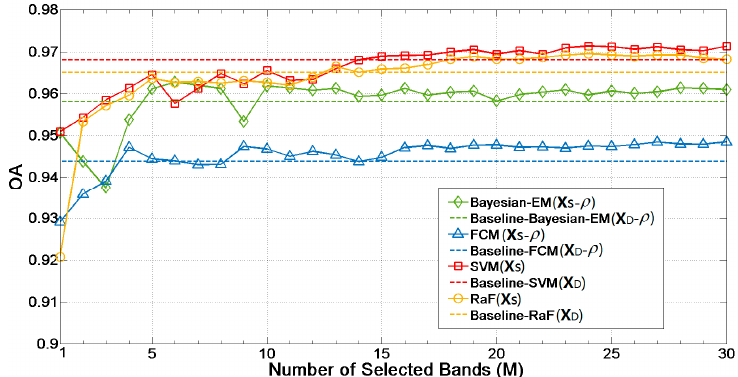
Figure 14. Binary CD accuracies obtained by the proposed CD approaches based on BS-DR (Umatilla County dataset). The unsupervised Bayesian-EM and FCM were applied on the compressed magnitude of X S (i.e., X S - ρ ) and the supervised SVM-based and RaF-based approaches were applied on the uncompressed X S . Baseline results (on X D ) are shown as dashed lines for comparison purposes.